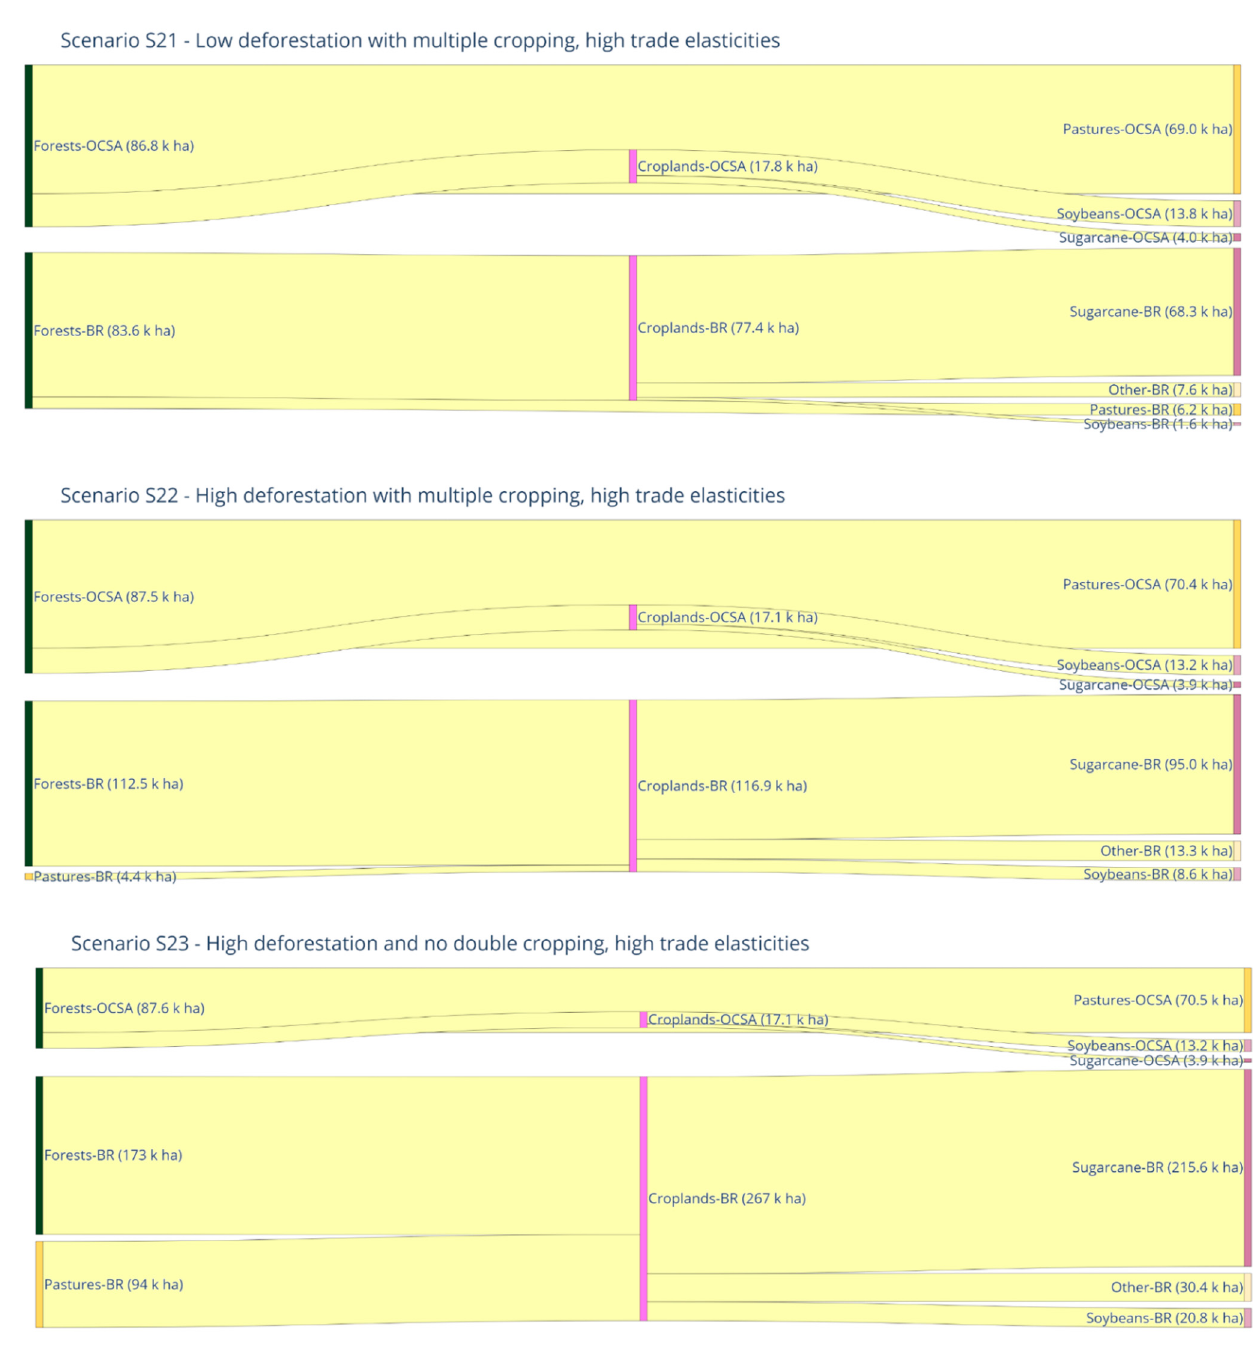
Figure 5. Land use change transitions for Brazil (BR) and other countries of South America (RSA) under high trade elasticities scenarios (S21, S22, and S23).